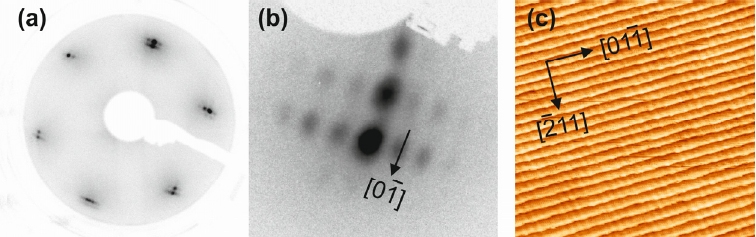
Figure 1. The clean Au(788) surface: ( a ) Low-energy electron diffraction (LEED) pattern, electron energy E p = 120 eV. ( b ) LEED pattern in off-normal incidence geometry, around a first order reflection, E p = 21 eV. ( c ) Scanning tunneling microscopy (STM) overview image (100 × 100 nm 2 ; sample bias V S = 2.2 V; tunneling current I T = 14.7